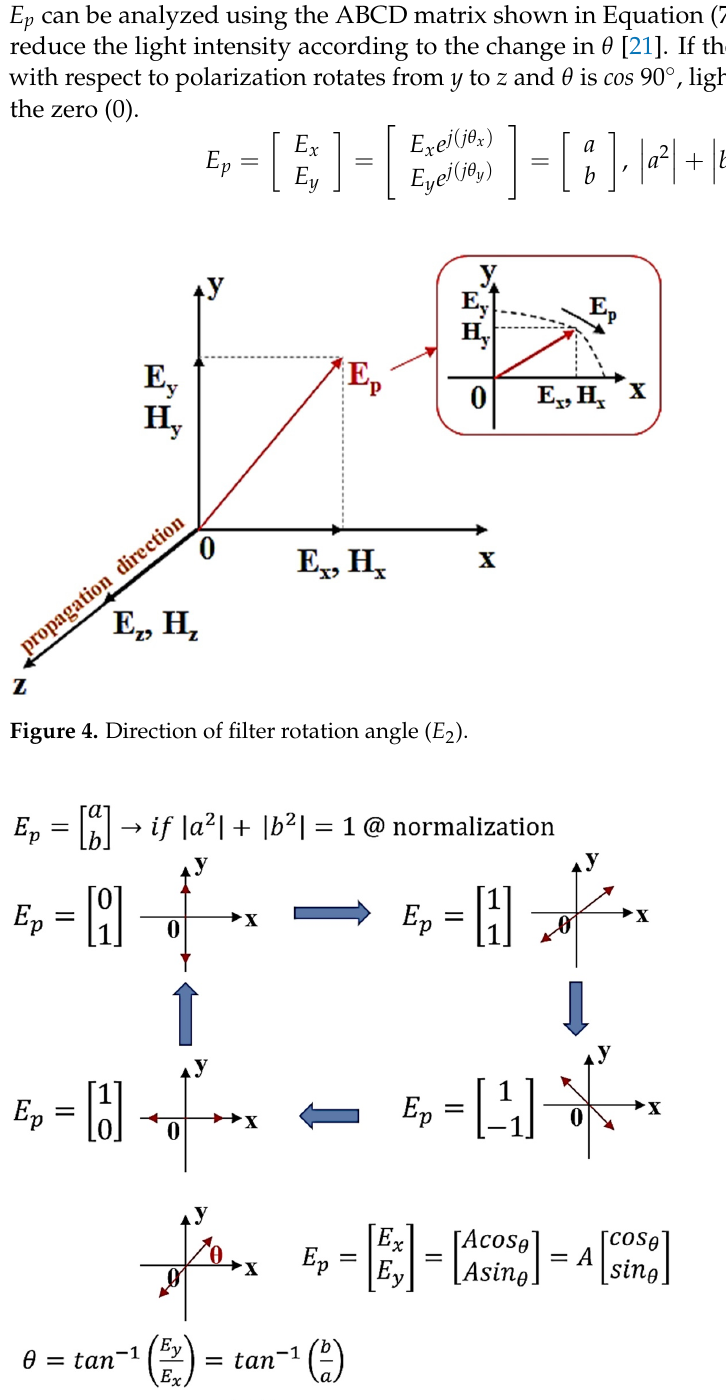
Figure 6. Characteristics of polarization according to the rotation angle of the filter ( E 2 ). For example, when the light reflection intensity ( I ref ) passes through two filters ( θ Ep = 90° difference) ( E 1 = 0°, E 2 = 90°), the light reflection intensity ( I ref ) at the p 3 position is reduced by more than half. Eventually, the intensity of light reflection ( I ref ) is lowered by